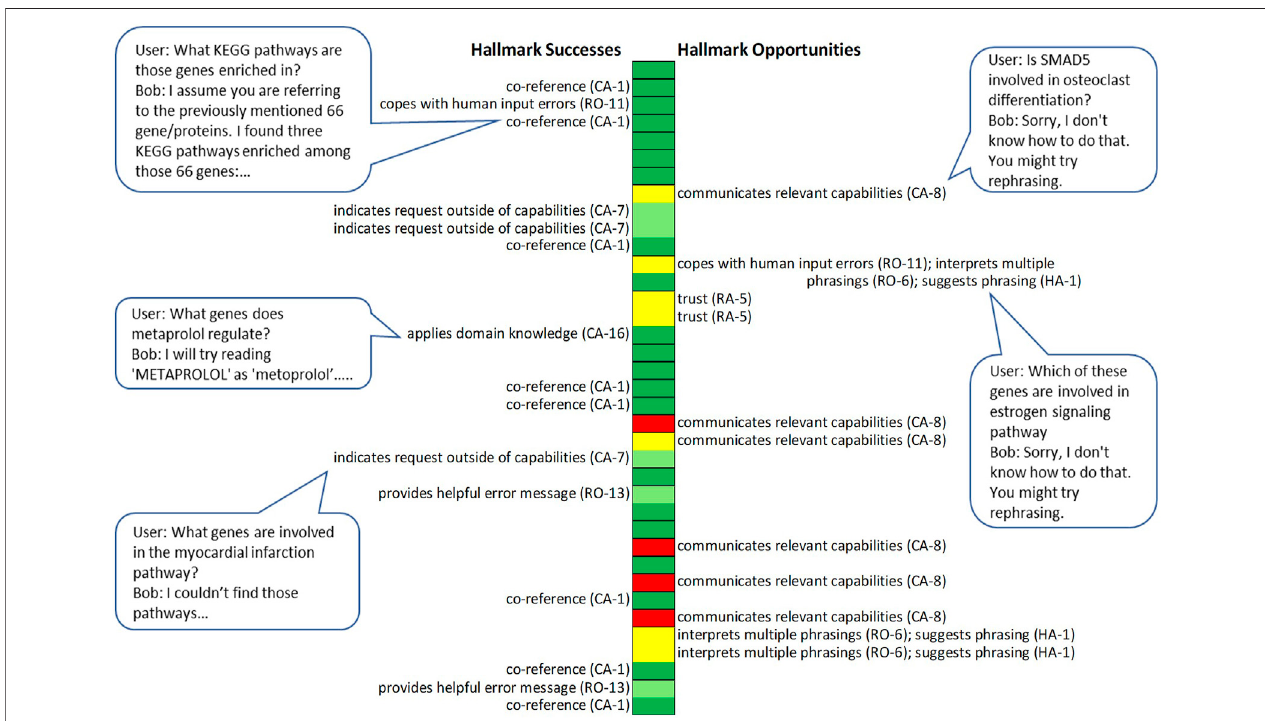
FIGURE 11 | Hallmark successes and opportunities in a researcher session with Bob. Each block outlined in black marks a single or set of utterances aimed at obtaining a particular kind of information or achieving a particular action. Colors indicate the assessment of each Bob response: dark green represents appropriate biologicalanswer oraction; lightgreenrepresentsahelpful suggestion; yellow representsan unhelpful or misleading response for which thehumanpartnerlater founda way to obtain what they were looking for; red represents an unhelpful or misleading response to a query for which the human partner never obtained an answer. Bubbles show selected single exchanges from the